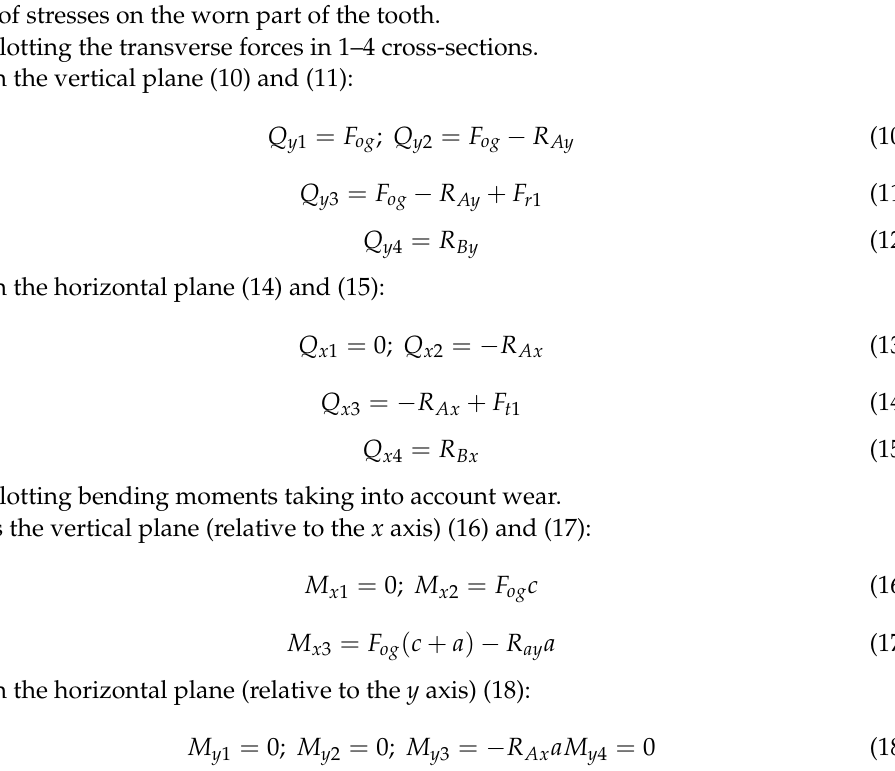
Vertical plane Horizontal